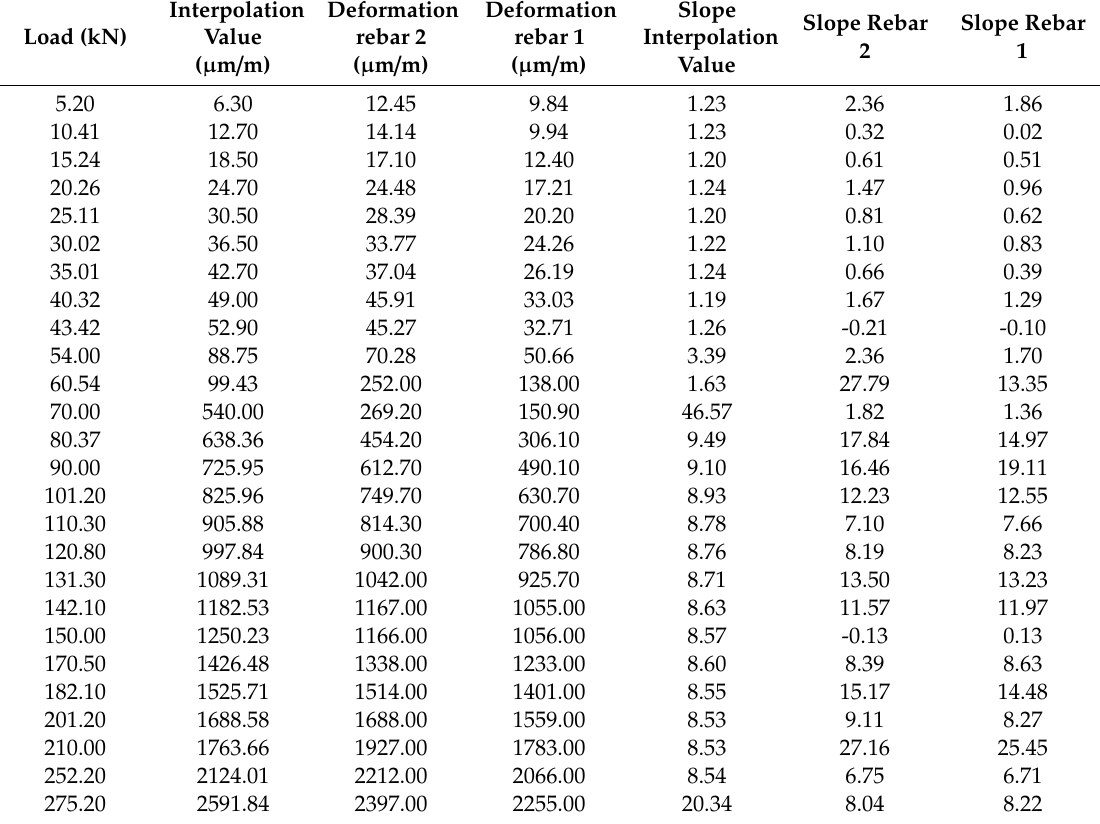
Table 12. Slope values of theoretical deformation curves and of rebars 1 and 2.